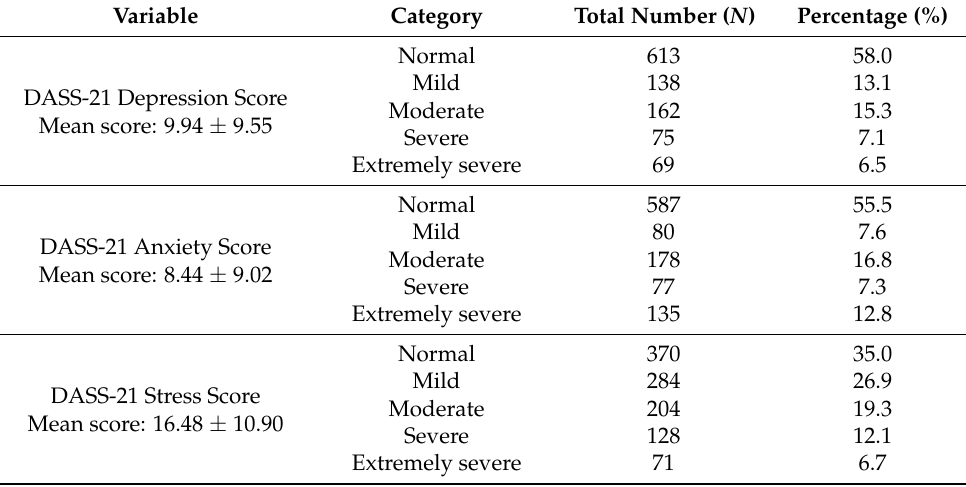
Table 3. Depression, Anxiety and Stress Scale—21 items (DASS-21) final